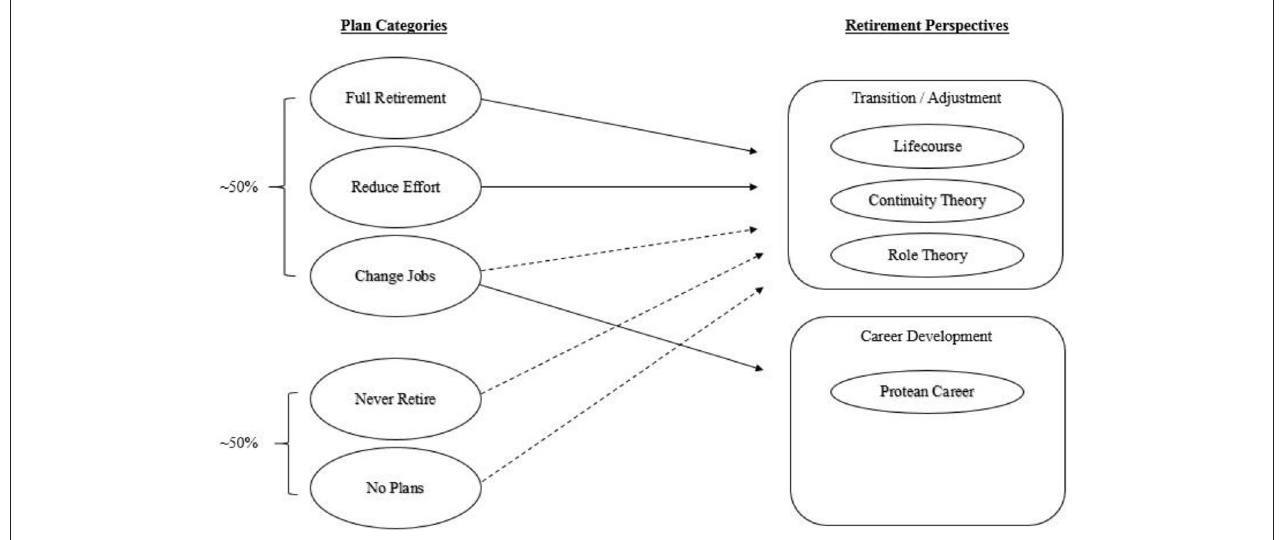
FIGURE 2 | Relative prevalence of plan categories from first-wave Juster (1992) and their conceptual relations with retirement’s psychological perspectives.